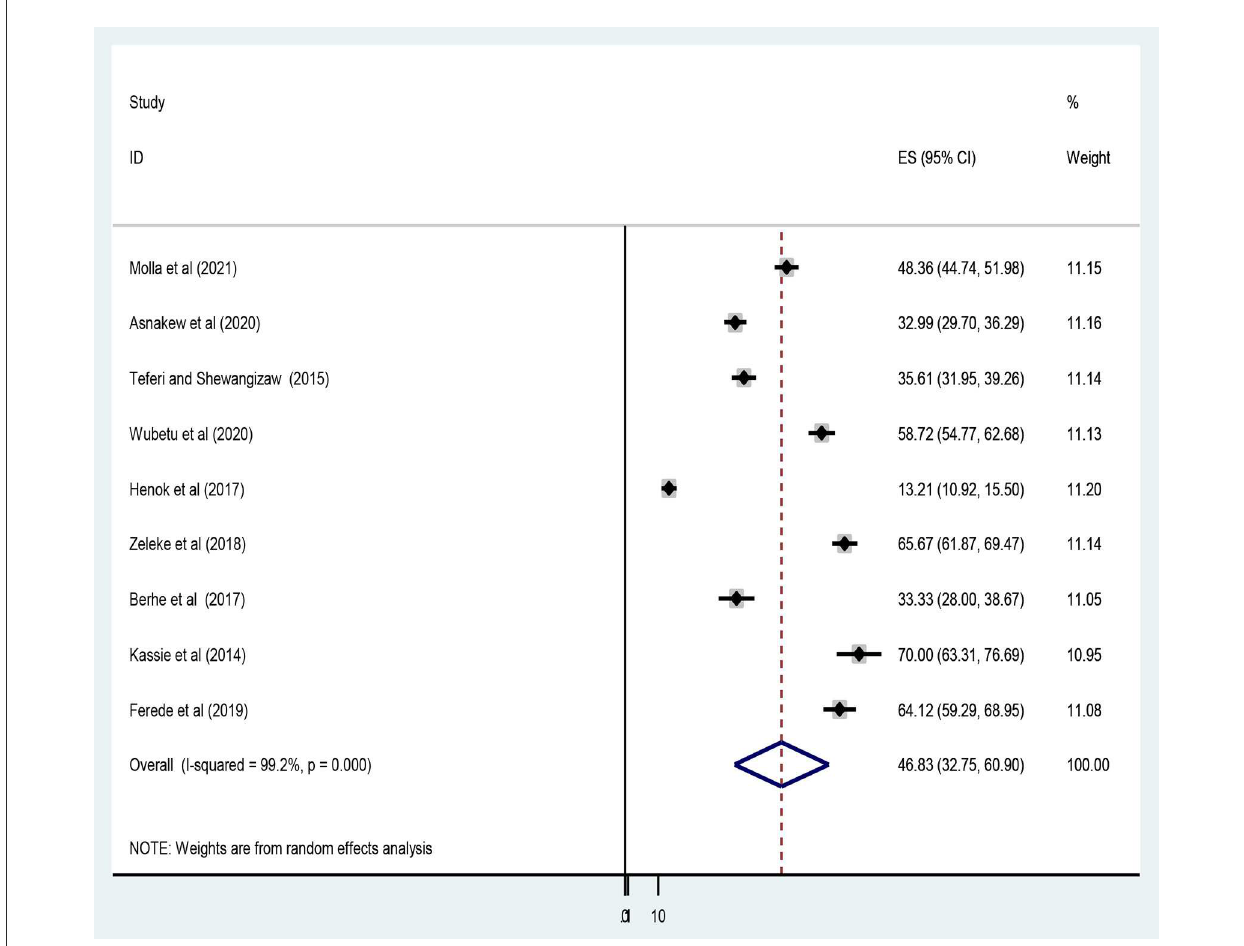
FIGURE4 Forest plot showing the pooled level of favorable attitudes toward epilepsy among